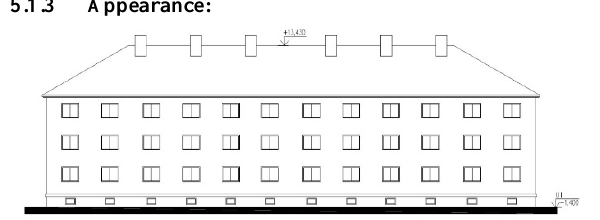
Figure 1. Documented building – east view